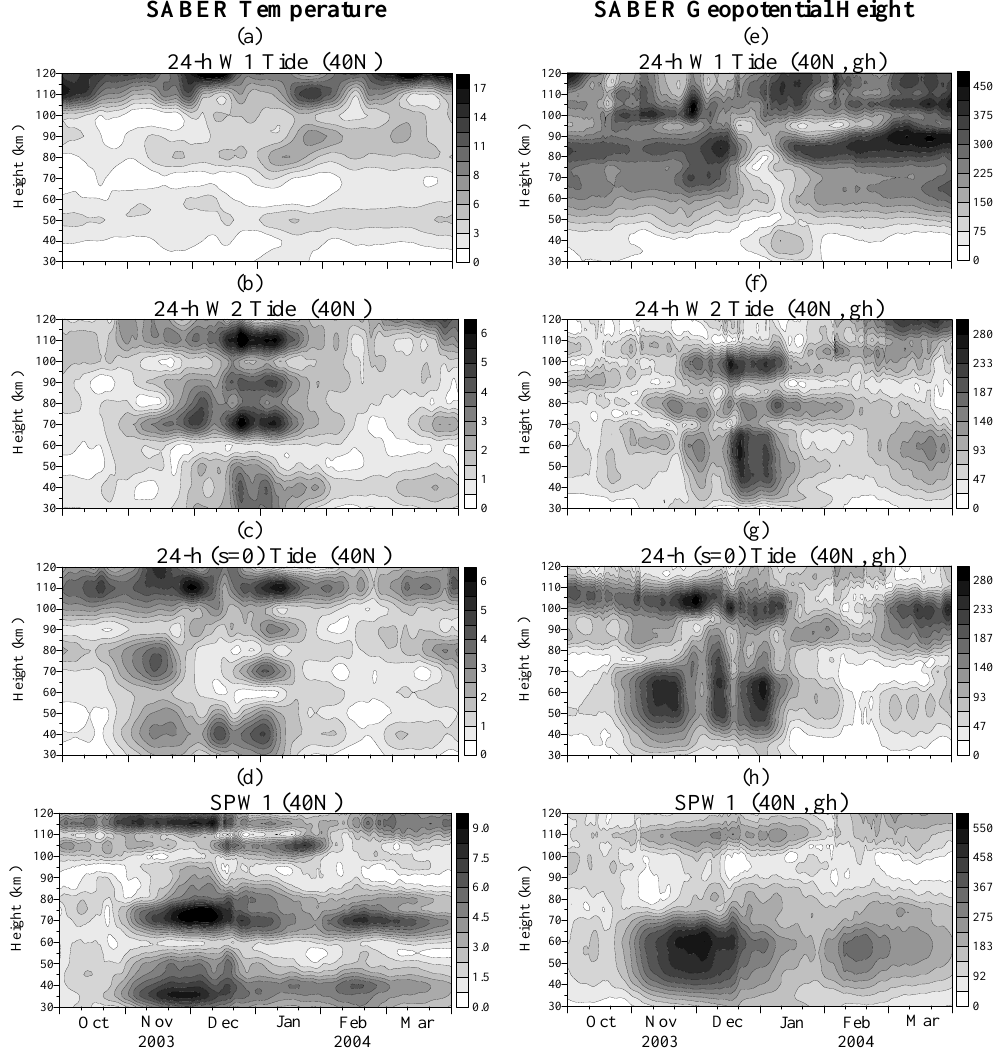
Figure 4 Fig. 4. Altitude-time cross sections of the following amplitudes: migrating W1 tide ( a and e ), nonmigrating W2 tide ( b and f ), nonmigrating s =0 tide ( c and g ), and SPW1 ( d and h ) seen in the SABER temperatures (left column of plots) and geopotential heights (right column of plot) at 40 ◦ N; the temperature amplitudes are in Kelvin, while those in the geopotential height – in geopotential meters. take place at the altitudes where the temperature waves have minima. Figure 5 (left column of plots) presents the altitude-time cross sections at 40 ◦ N of the migrating W1 (a) tide (the same as that in the Fig. 4) and the nonmigrating W3 (b) and E1 (c) tides. In order to facilitate the comparison again the nonmi- grating W3 and E1 tides have the same scale. The plots (b) and (c) reveal that the nonmigrating W3 and E1 amplitudes at 40 km height are stronger than those at 90 km. This com- parison supports the 2-D LS spectral results shown in Fig. 2b (bottom plots). In this case the W3 and E1 nonmigrating diurnal tides can be generated by a nonlinear interaction be- tween the SPW2 and the migrating diurnal tide. The